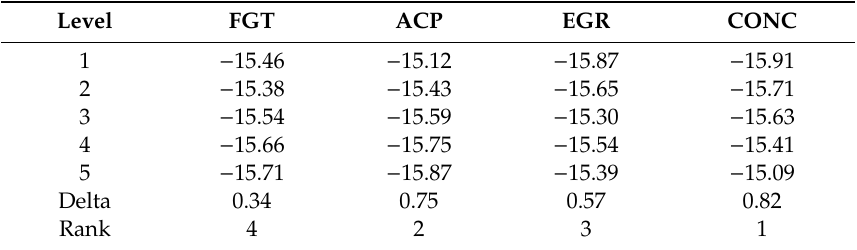
Table 5. Response table of the signal-to-noise ratio (SNR) taken from Minitab.